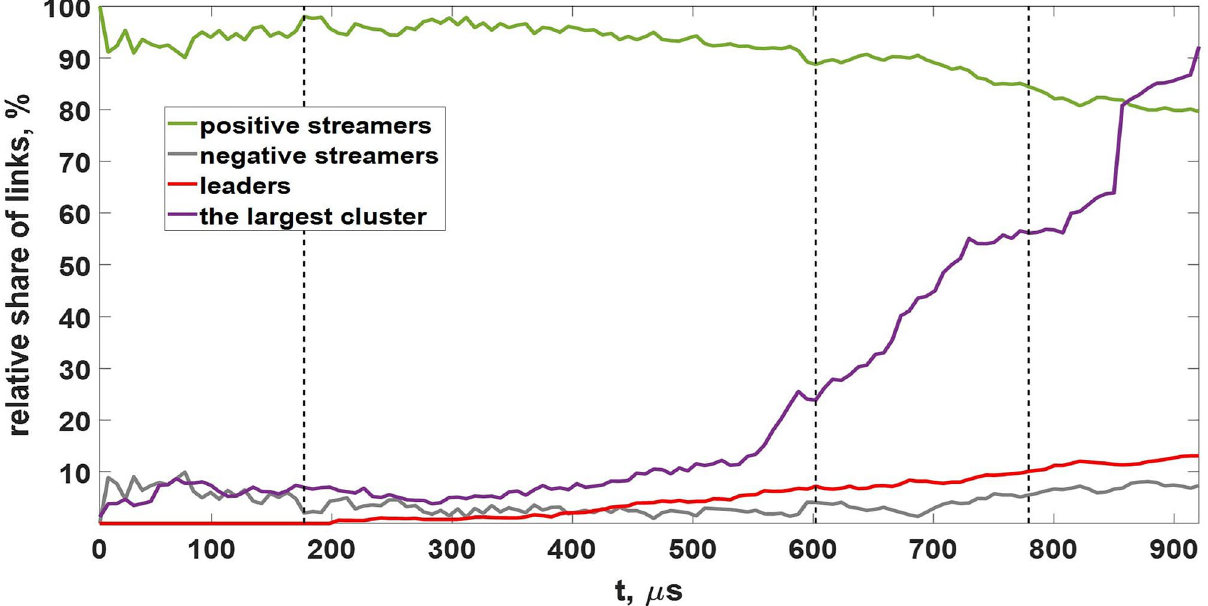
Figure 12. Dependence curves of the system composition in terms of positive and negative streamers and 1 S/m regardless of their polarities). Also shown the leaders (channel segments with conductivities σ ≥ dynamics of the relative share of model links belonging to the main (the largest) cluster. Vertical dotted lines correspond to the moments of time shown in panels ( a–c ) in Fig.